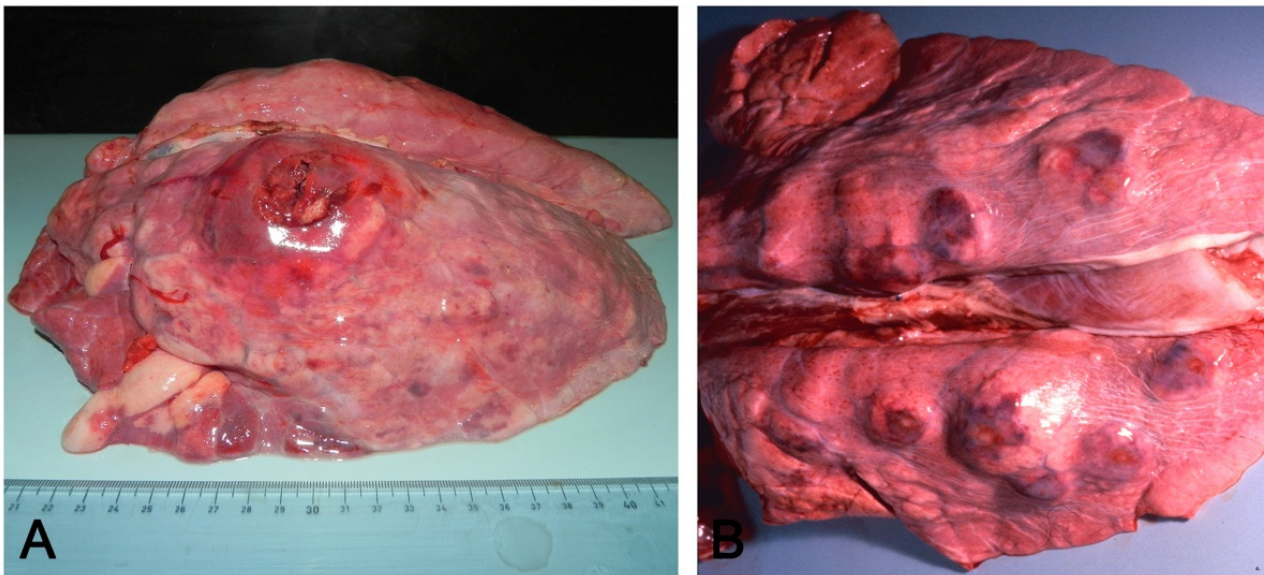
Figure 3. Acute ( A ) and chronic ( B ) pleuropneumonia by Actinobacillus pleuropneumoniae : in ( A ), an acute, locally extensive, and protruding nodule coexists with associated pleuritis localized in the craniodorsal side of the left lung lobe, referable to A. pleuropneumoniae and cranioventral pneumonia. In ( B ), multifocal nodules of the chronic form.